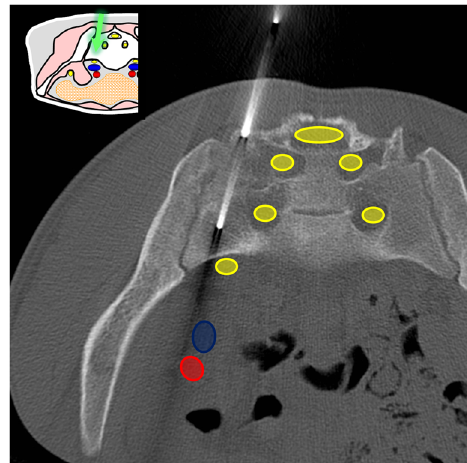
Fig. 6 A 24-year-old man presenting with multiple lytic lesions and no known primary tumour. A posterior approach targeting a sacral lytic